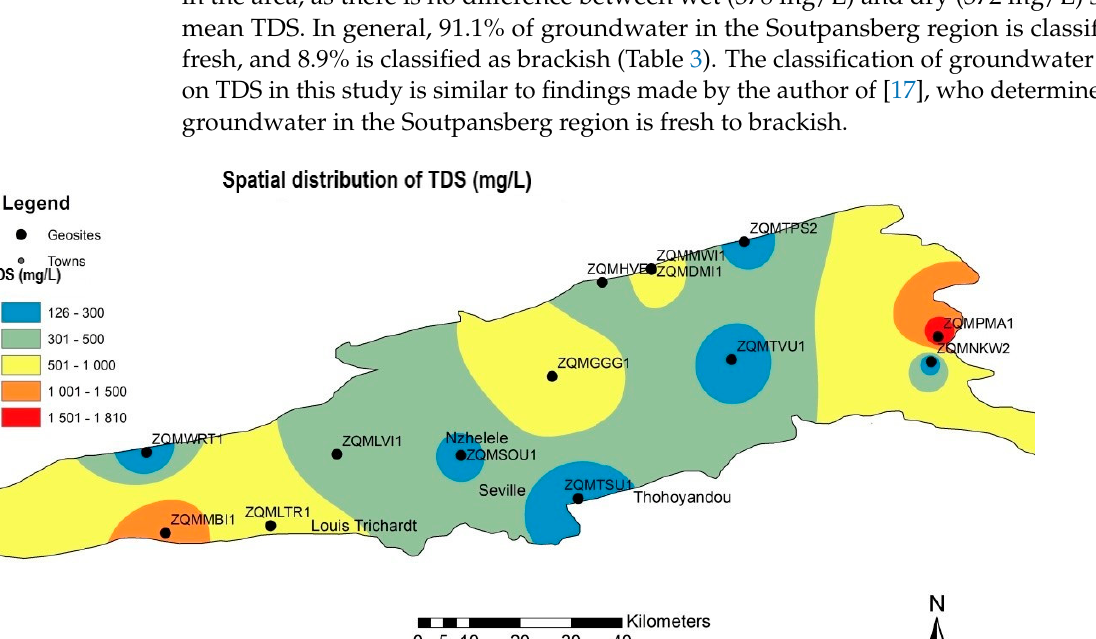
Figure 4. Spatial distribution of chloride in the Soutpansberg region. The concentration levels of various contaminants are presented in Table 1, where the cation dominance order is Na + > Mg 2+ > Ca 2+ > K + , and that of the anions is HCO 3 − > Cl − > SO 42 − > NO 3 − > F − . In terms of water types classified by a Piper diagram [39], a study by the authors of [43] used this diagram to deduce anthropogenic and geogenic sources of con- taminants in groundwater. The dominant water types in the Soutpansberg were Ca-HCO 3 (35.7%) and mixed Ca-Mg-Cl (35.7%), as presented in Figure 8. Ca-HCO 3 is classified as typical shallow, fresh, and recently recharged water. Bicarbonate ion (HCO 3 − ) concentra- tions in groundwater ranged from 5 to 612 mg/L, with a mean of 170 mg/L. In terms of seasonal variation, a mean HCO 3 − concentration of 141 and 178 mg/L were recorded in wet and dry seasons, respectively, indicating a seasonal variation difference of 37 mg/L (20.8%). The majority of samples and mean concentrations of HCO 3 − are within the [20,21] standards (in the absence of groundwater quality standards). Concentration levels of Cl − ranged from 5 to 755 mg/L, with a mean of 75 mg/L. The spatial distribution of mean Cl − concentrations in groundwater of the Soutpansberg region indicates that it is highly con- centrated where TDS concentrations are high (Figure 4). The mean concentrations of Cl − in groundwater are slightly higher in the wet season (99 mg/L) compared to those in the dry the season (68 mg/L). Monitoring sites with high salinity were associated with mixed